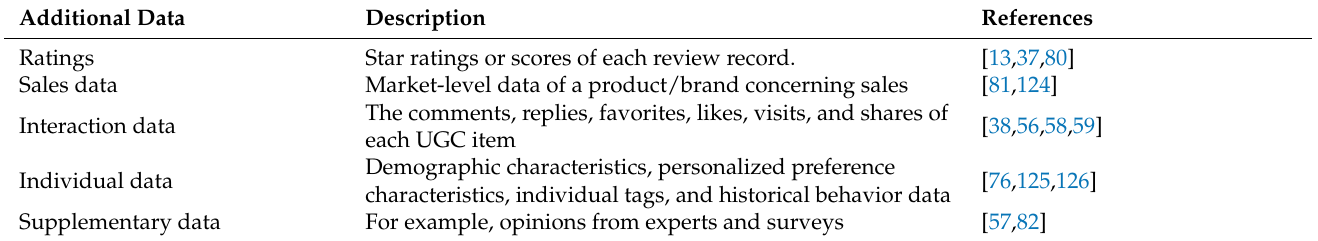
Table 5. Additional data